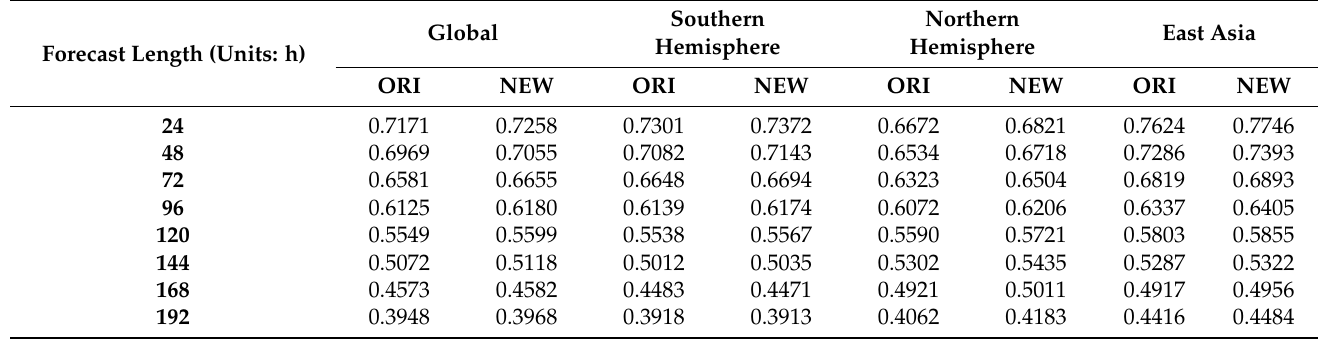
Table 10. ACC of surface soil temperature between GRAPES forecast and GLDAS over different